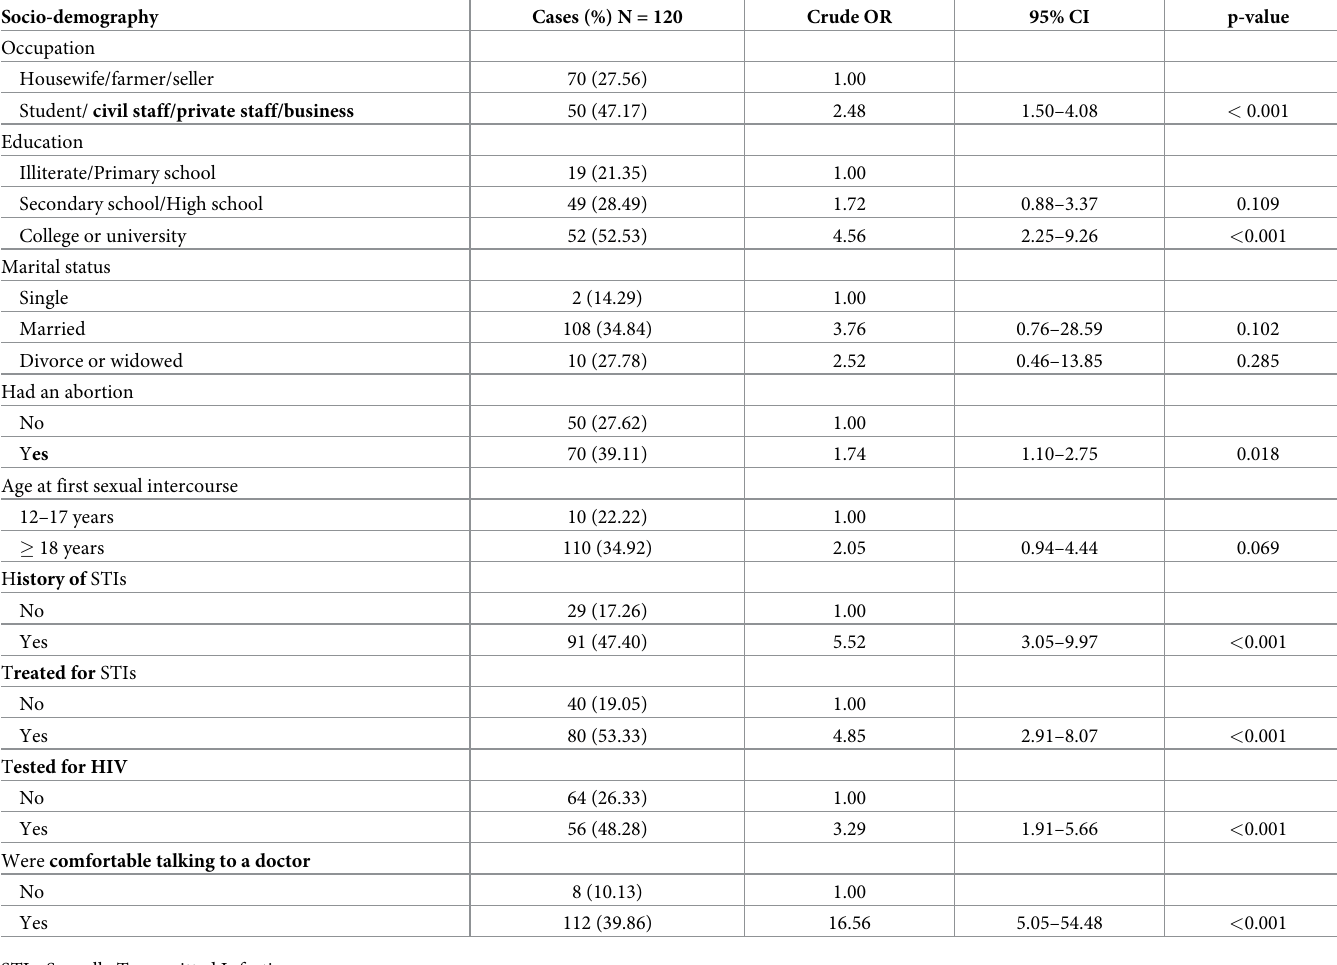
Table 1. Bivariate analyses of association between the presence of cervical cancer screening and participants’